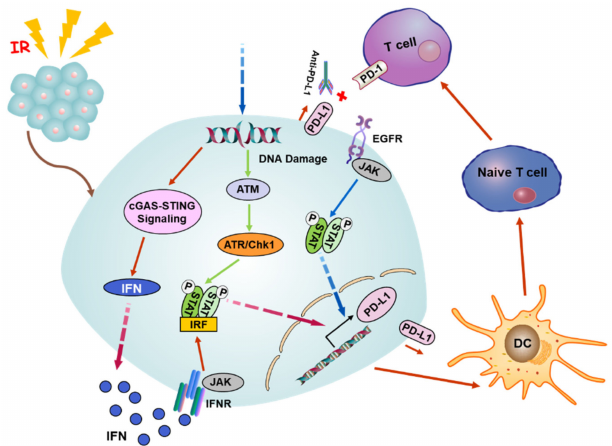
Figure 2. A potential mechanism of radiation-induced abscopal e ff ect. Radiation triggers the release of nuclear DNA into the cytoplasm, and cGAS can recognize the damaged DNA and activate the cGAS-STING pathway to induce the secretion of IFN-I that can bind to the cell surface receptor INFR to activate the axis of Janus kinase / signal transducer and activator of transcription / interferon regulatory factor (JAK / STAT / IRF). Meanwhile, the DNA damage also stimulates the ATM / ATR / Chk1 signaling followed by the STAT-IRF pathway. The phosphorylated STAT / IRF complex can be translocated to the nucleus and targets the promoter of PD-L1 to boost the expression of PD-L1. Alternatively, the expression of PD-L1 is upregulated by EGFR receptor activation through JAK / STAT signaling upon radiation. The combination of anti-PD-L1 and PD-L1 breaks the connection between PD-L1 and PD-1, making tumor cells unable to escape from the immune supervision of T cells. Abbreviations: cGAS, cyclic GMP-AMP synthase; STING, stimulator of interferon genes; IFN-I, type I interferon; PD-L1, programmed death ligand 1; EGFR, epidermal growth factor